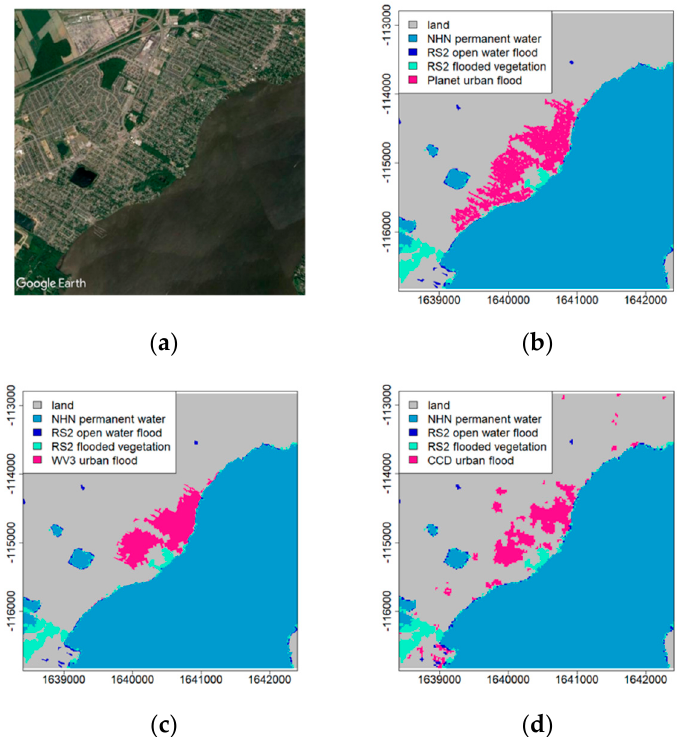
Figure 7. Sainte-Marthe-sur-le-Lac: ( a ) High-resolution natural colour image from GoogleEarth TM ; ( b ) urban flood extents derived from a PlanetScope NIR image acquired on April 29, 2019; ( c ) urban flood extents derived from a WorldView-3 image acquired on May 5, 2019; ( d ) urban flood extent derived from thresholding a CCD image between γ post and γ co. Background classification for panels b-d is an EGS RS2 flood map from May 3, 2019. Table 5. Classification accuracy of the CCD flood extent product over Sainte-Marthe-sur-le-Lac mapped from Sentinel-1